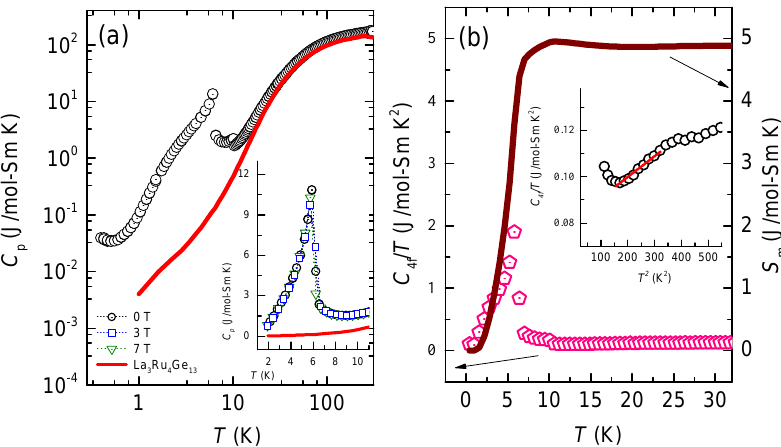
Figure 3. ( a ) The specific heat C p ( T ) of Sm 3 Co 4 Ge 13 in 0 T is presented in the main panel along with that of the lattice-analogue, La 3 Co 4 Ge 13 . The inset of ( a ) shows the low-temperature part at 0 T, 3 T and 7 T. A phase transition occurs at T N ≈ 6 K that is robust against applied fields upto 7 T. Shown in ( b ) are the quantities C 4 f / T and S m plotted against temperature. S m , in the vicinity of T N is lower than R ln(2) for a doublet. The inset shows the low temperature part of C 4 f ( T ) / T vs T 2 to extract the Sommerfeld coefficient as γ = 80(2) mJ/mol-Sm K 2